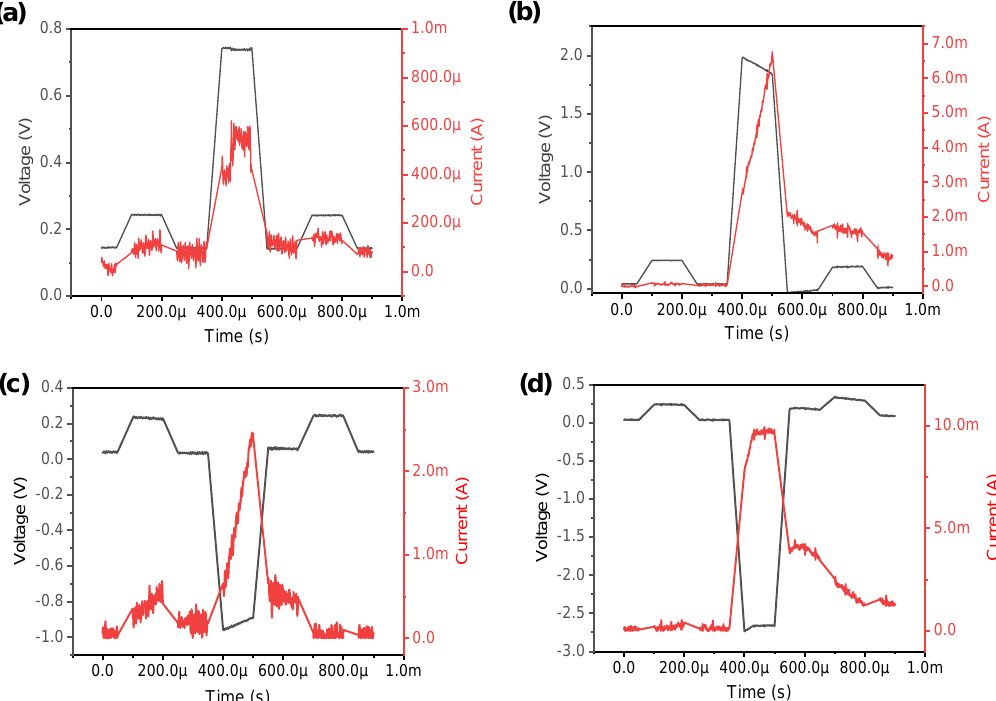
Figure 3. Pulse transient characteristics for ( a ) volatile switching, ( b ) set process, ( c ) reset process, and ( d ) negative-set behavior.